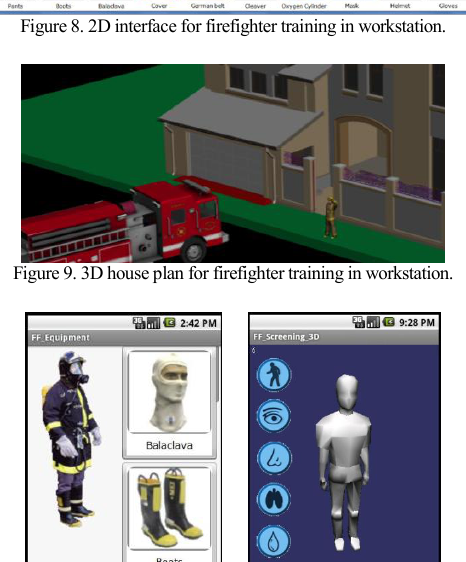
Figure 11. Distributed simulation that integrate cell phone and